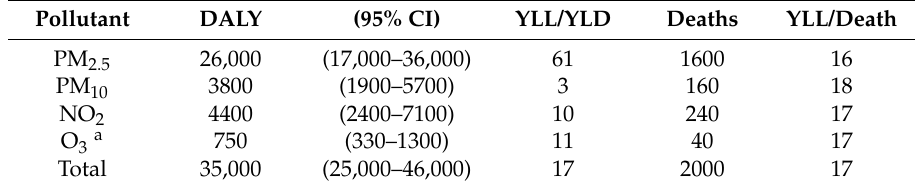
Table 5. Estimates of attributable disease burden for four main air pollutants in Finland in 2015.